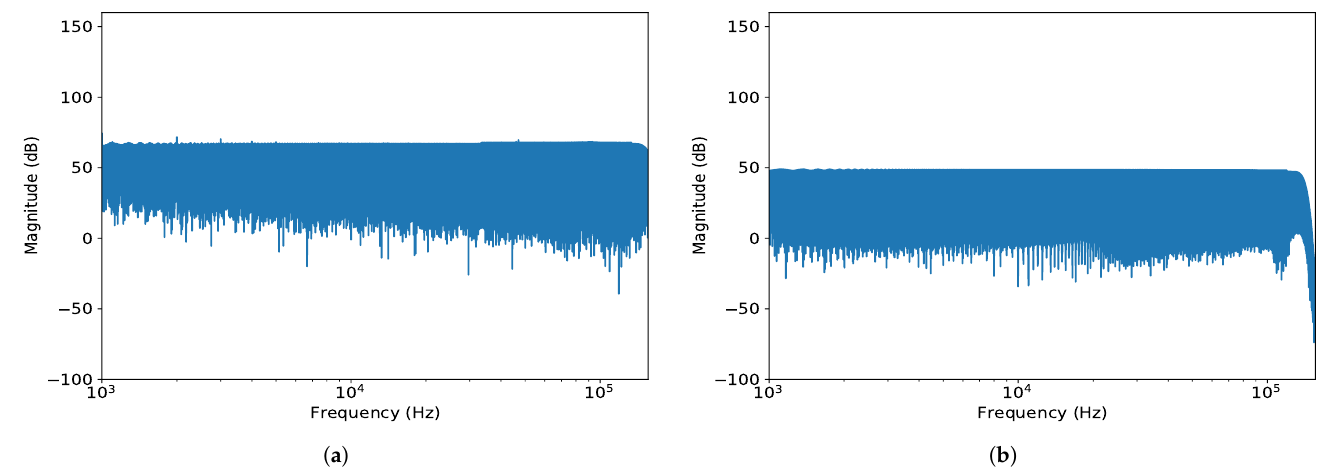
Figure 2. A comparison of the ADC’s response to the sweep signal between 1 Hz and 160 kHz plotted for both converters: ( a ) the response of ADS1672 operating at 312 kSPS and ( b ) the response of ADS127L01 operating at 256